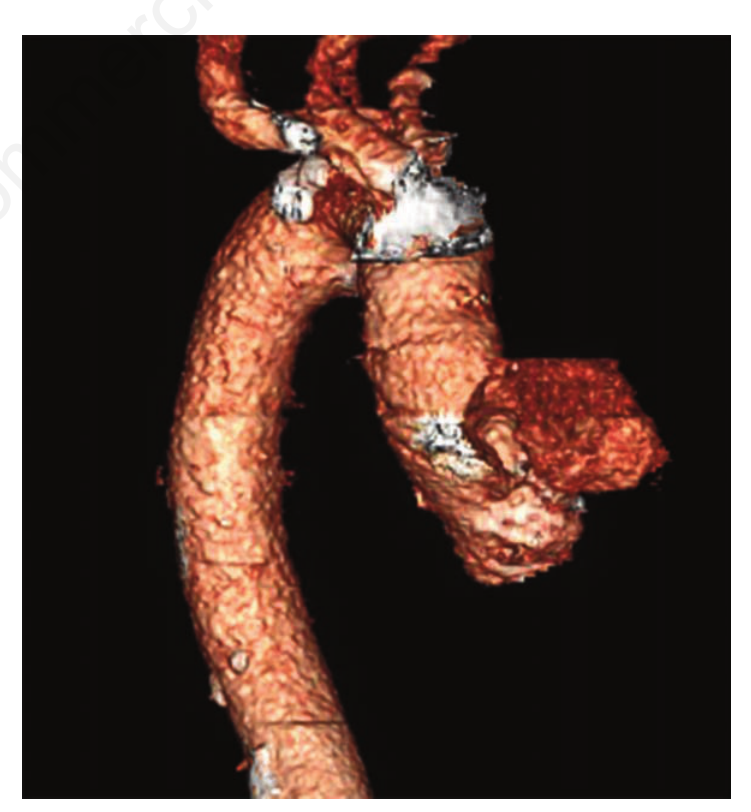
Figure 2. CTA Chest with 3-D reconstruction re-demonstrating a 3.4x2.25 cm pseudoa- neurysm of the proximal ascending